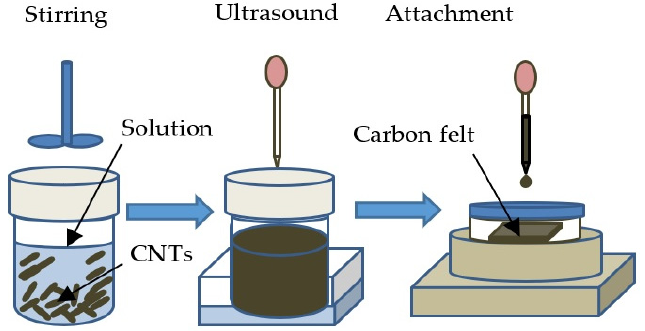
Figure 1. CNT dispersion and carbon fiber modification.